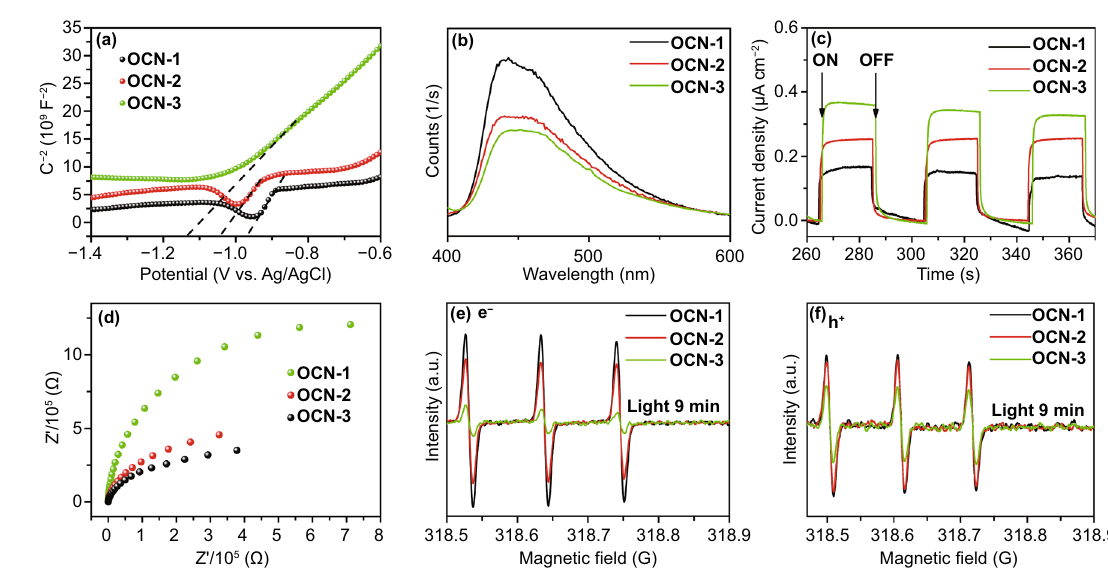
Fig. 4 a Mott–Schottky plots spectra, b steady-state photoluminescence (PL) spectra, c transient photocurrent responses, d EIS spectroscopies, e, f ESR spectra of e − and h + of OCN-1, OCN-2, and OCN-3 under visible-light irradiation for 9